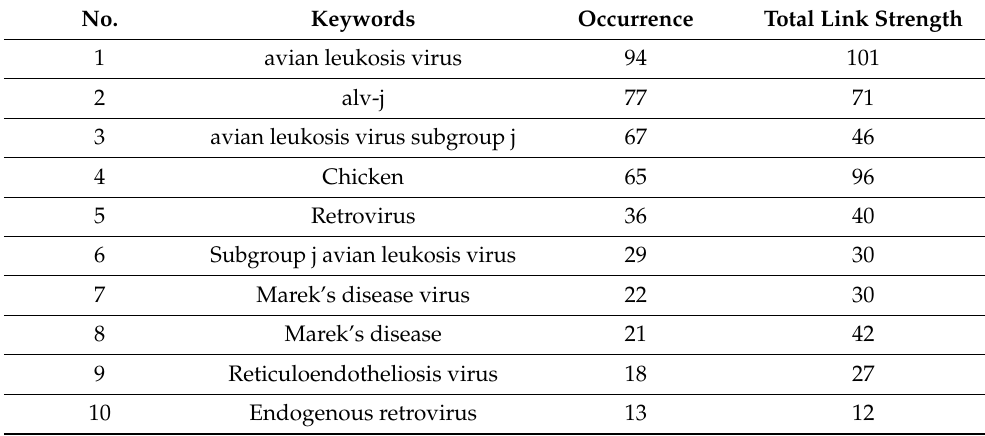
Figure 4. Authors’ keyword analysis for latest research trends on Avian Leukosis Virus literature from VOS viewer software. Table 6. Author-provided keyword analysis on Avian Leukosis Virus literature.